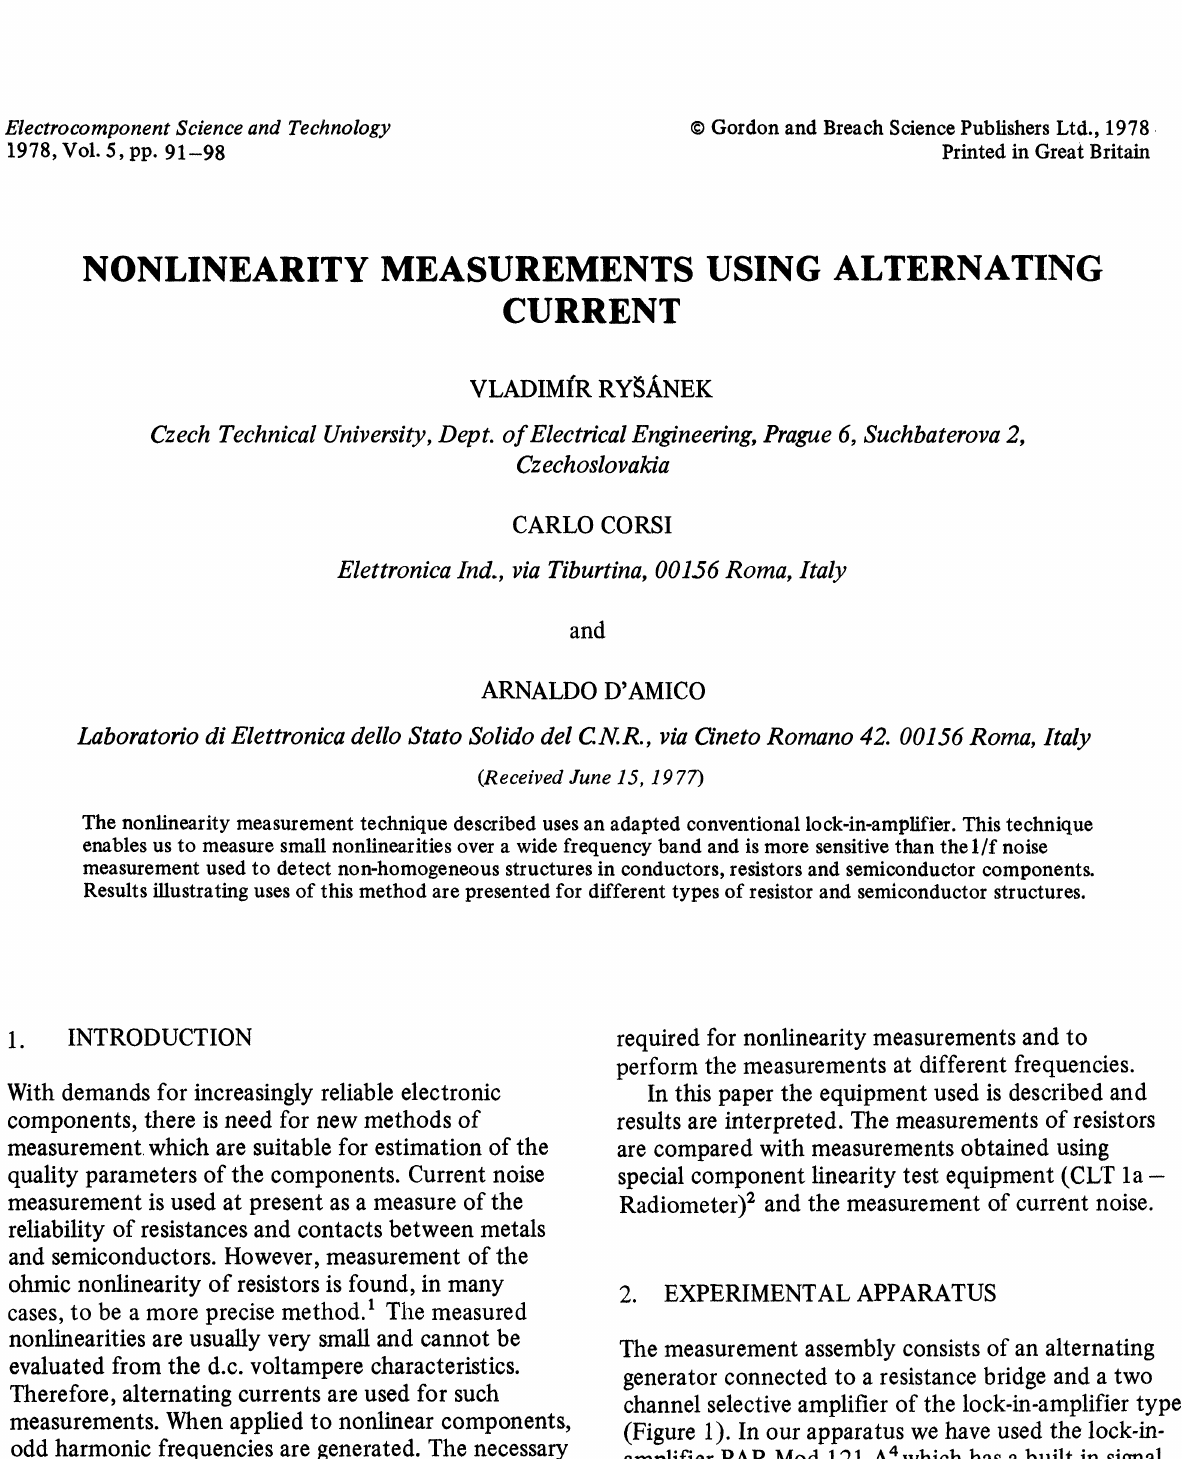
Basic equipment